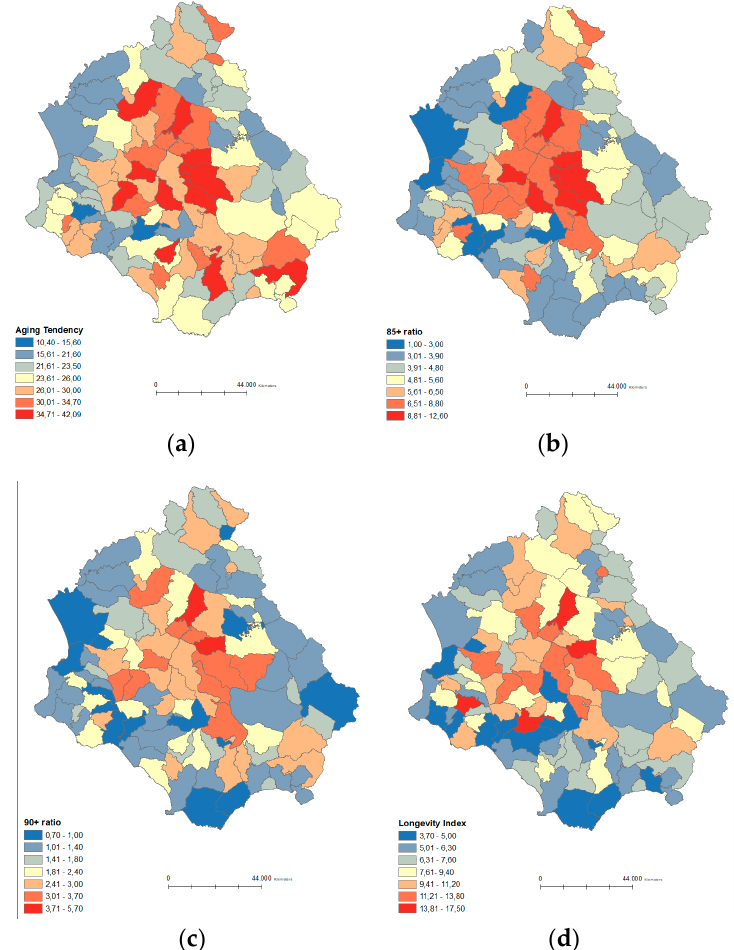
Figure 5. Results of the GWR models for Aging tendency, 85+ ratio, 90+ ratio and Longevity index showing the local R 2 . Note: ( a ) local R 2 for Aging tendency; ( b ) local R 2 for 85+ ratio; ( c ) local R 2 for 90+ ratio; ( d ) local R 2 for Longevity index. Table 5. Performance comparison between OLS regression and GWR